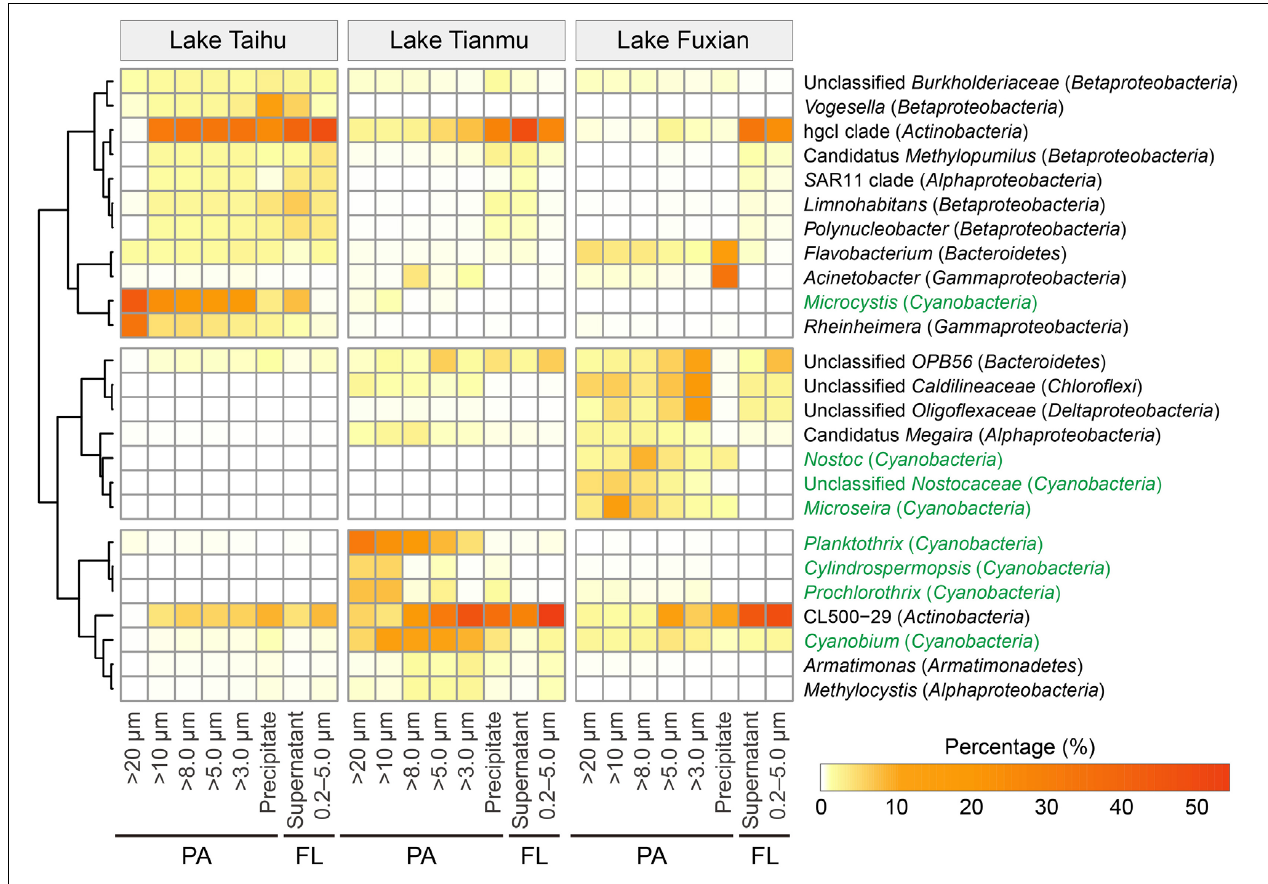
FIGURE 7 | Heatmap of the 25 major genera, including the top 10 genera in each lake. Genera in green are associated with the photosynthetic autotrophic Cyanobacteria . PA, particle-attached; FL,